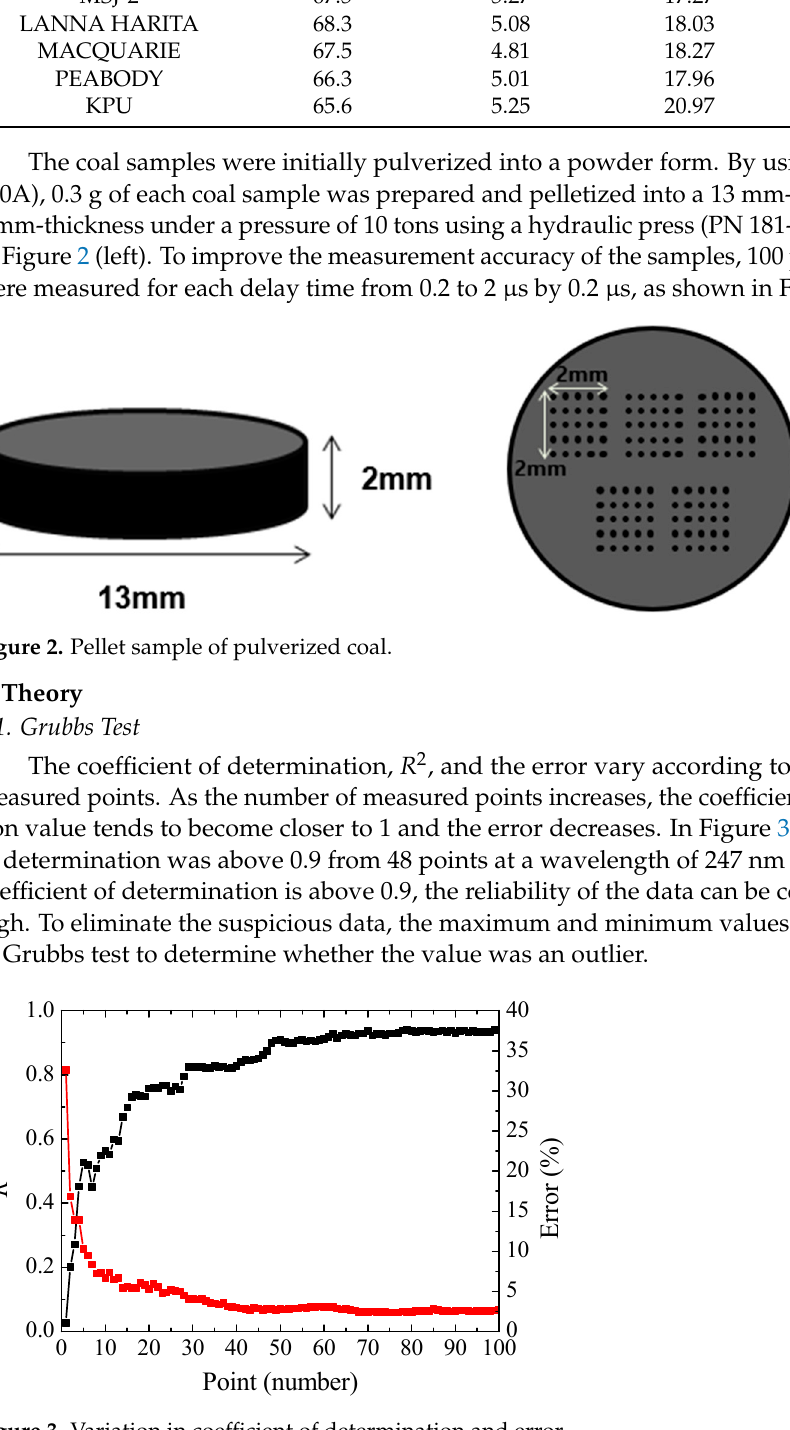
Figure 3. Variation in coefficient of determination and error.